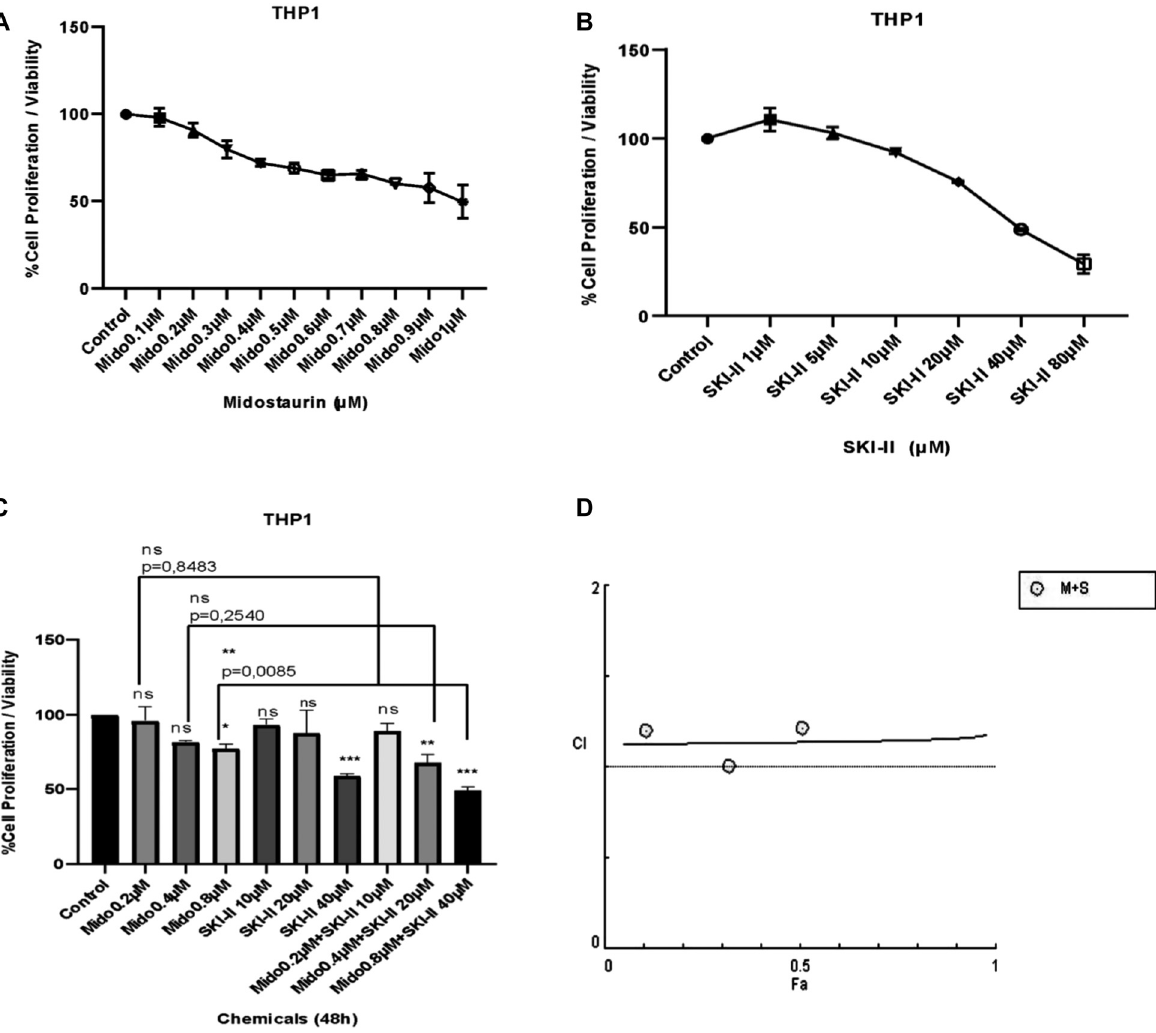
Figure 2: Cytotoxic effect of midostaurin (A), SKI II (B) and combinations (C) in THP1 cells at 48 h. Data are shown as the mean ± SD of at least two independent experiments. Calcusyn analysis of midostaurin plus SKI II (D).*p<0.05, **p<0.005, ***p<0.0001 vs.